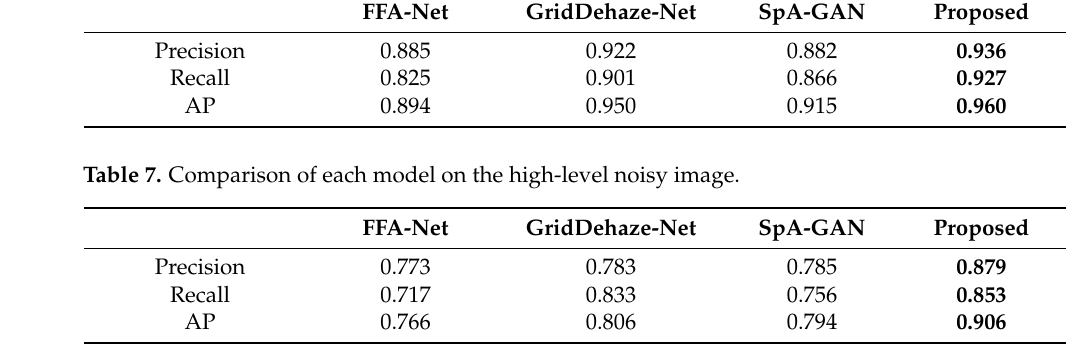
Figure 15. Comparisons of each model’s denoising performance on different level real ‐ noise images.